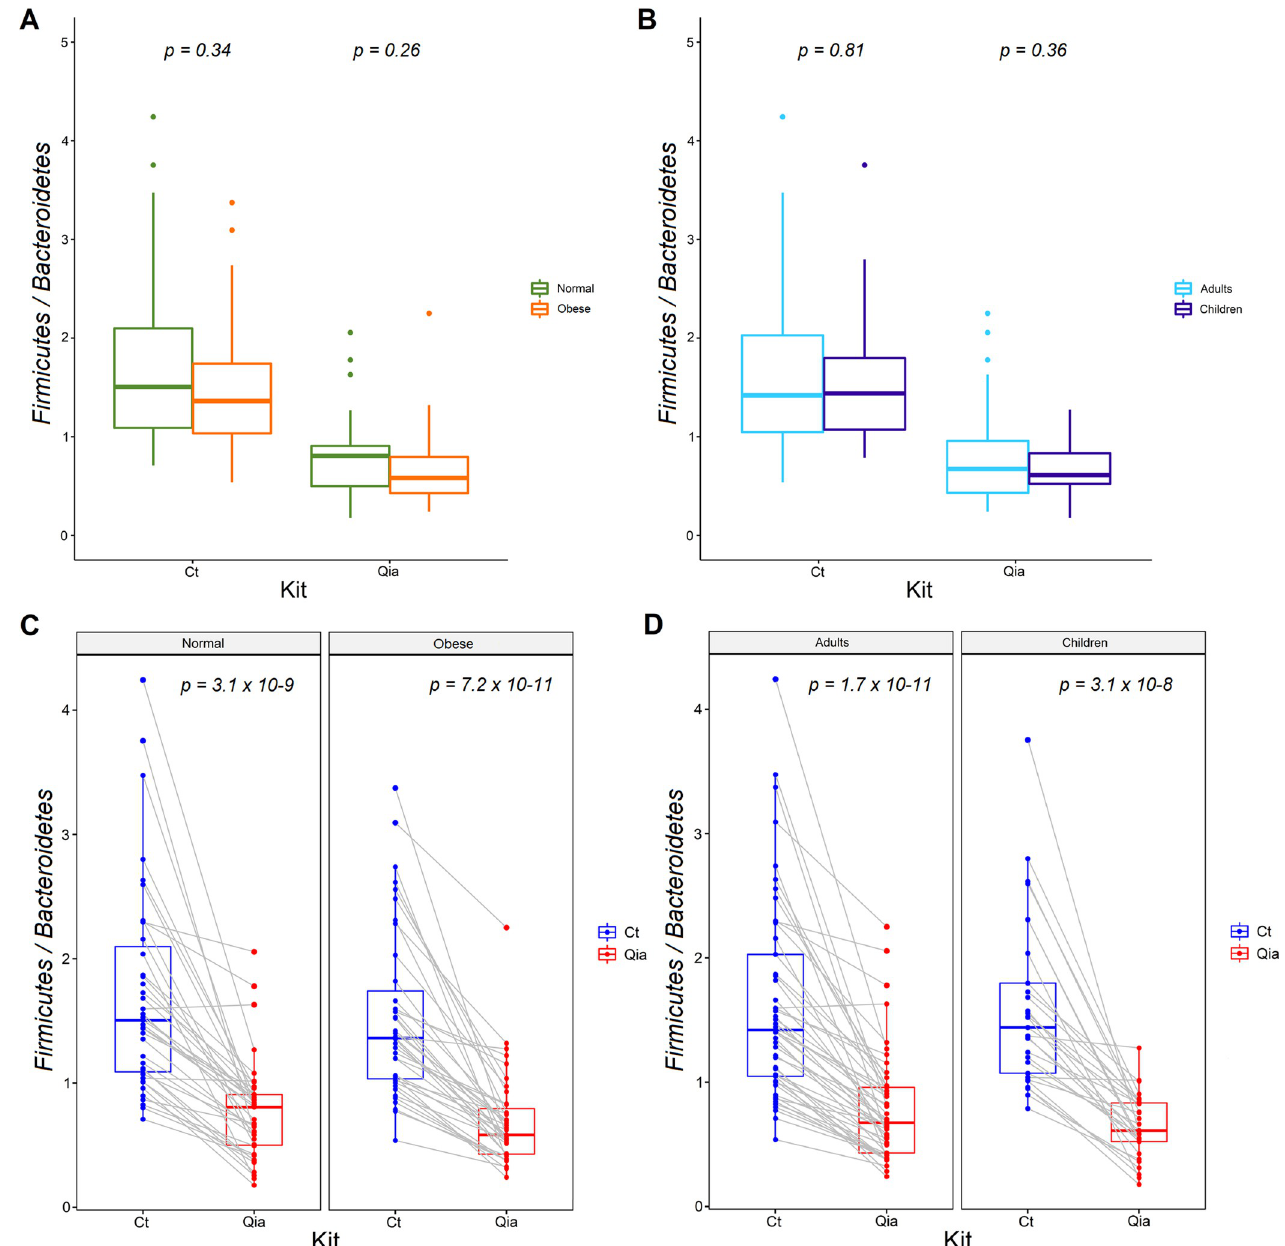
Fig 4. Firmicutes / Bacteroidetes (F/B) ratio of subgroups. A. F/B ratio distribution between normal vs. obese group. B. F/B ratio distribution between adult vs. children group. C. F/B ratio distribution between Ct and Qia kits in Normal and obese groups, respectively. The gray lines represent the same sample pair. D. F/B ratio distribution between Ct and Qia kits in adults and children groups,